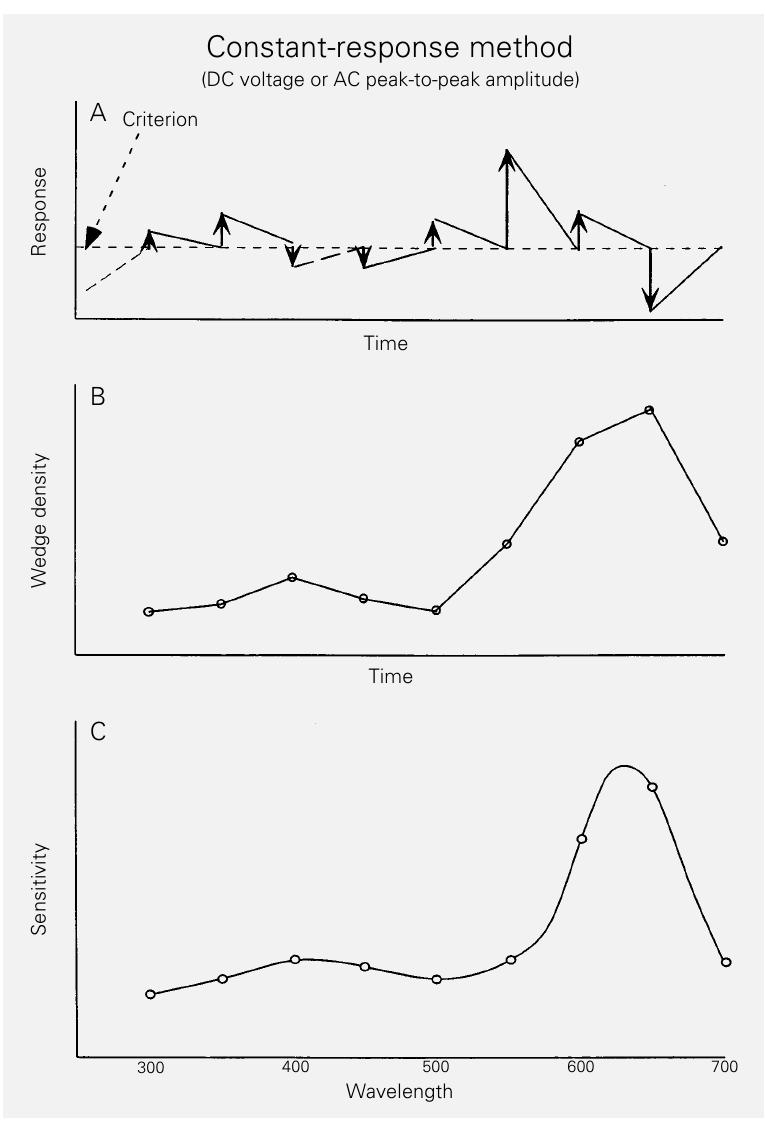
Figure 1 - Schematic illustration of constant-response methods. A shows a schematic response of the photoreceptor to wavelength and intensity changes. At the beginning, the wavelength is set to 300 nm, and the wedge density is stepped down until the response reaches the criterion amplitude. Then the wavelength is stepped up to the next value, the response departs plus/minus from the criterion amplitude, and the wedge density is stepped in the appropriate direction until the response again reaches the criterion ampli- tude. This process continues until all wavelengths have been tested. B illustrates the wedge density changes with time that correspond to the response changes in A . The quantum fluxes necessary to elicit criterion responses at each wavelength are calculated from the wedge densities in B , and the spectral sensitivity in C is calculated as the reciprocal of these quantum